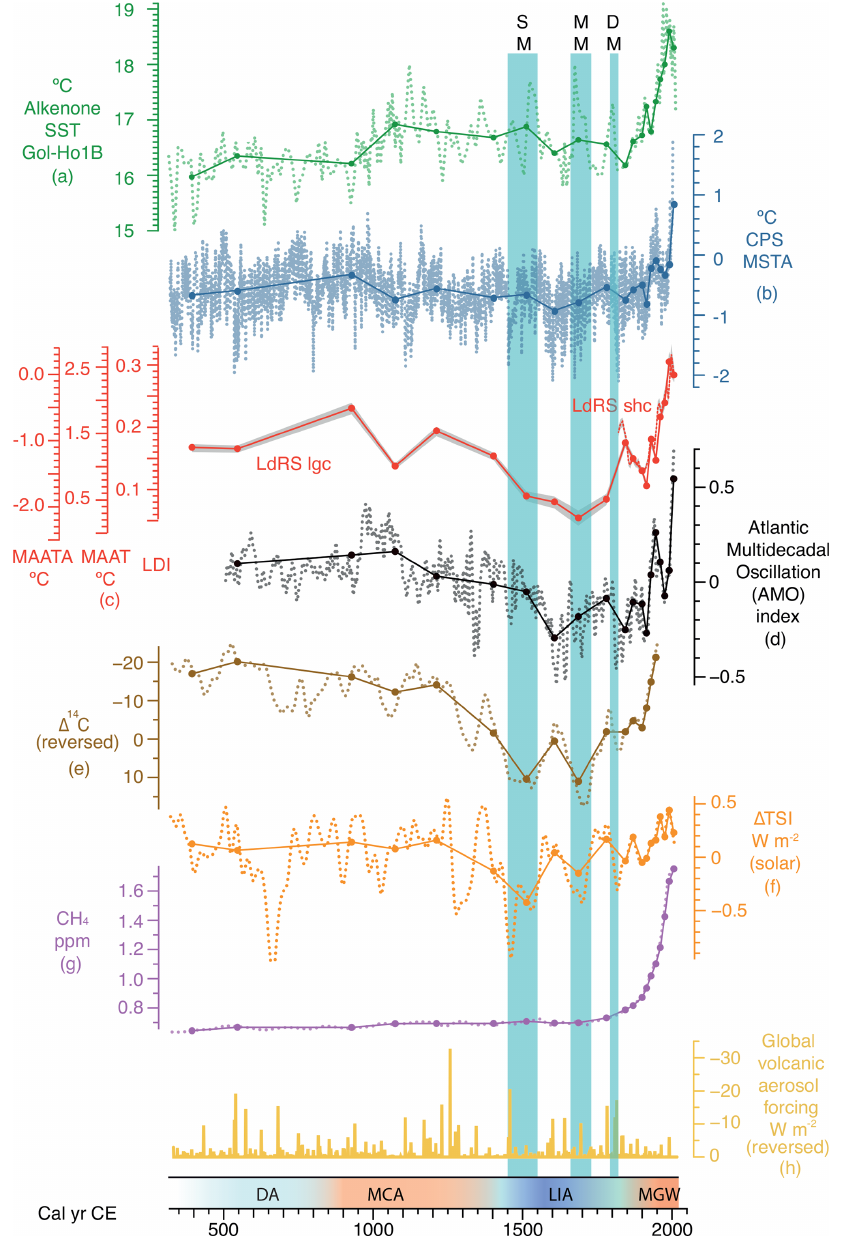
Figure 6. Comparison of the LDI record and the reconstructed temperatures for the last ∼ 1500 years of LdRS with marine and terrestrial temperature records, Atlantic multidecadal oscillations, solar radiation, greenhouse gases, and volcanic eruption records. Original data are shown by dashed lines. Solid dots represent the same time averaging as the LDI data in LdRS lgc (data were linearly interpolated and time averaged to the same resolution as the sampling points of LdRS lgc) to facilitate the Pearson correlation: (a) alkenone sea surface temperatures (SST, ◦ C) of the core Gol-Ho1B_KSGC-31 (Gulf of Lion: NW Mediterranean Sea; Sicre et al., 2016). (b) Composite-plus- scaling (CPS) mean summer temperature anomaly reconstruction from tree-ring records in Europe with respect to 1974–2003CE (MSTA, ◦ C) (Luterbacher et al., 2016). (c) LDI record along with the reconstructed mean annual air temperatures (MAAT, ◦ C) and mean annual air temperature anomalies with respect to 1979–2008CE (MAATA, ◦ C) for the last 1500 years in LdRS; (d) Atlantic Multidecadal Oscillation (AMO) reconstruction (Mann et al., 2009); (e) (cid:49) 14 C in the atmosphere (reversed) (Reimer et al., 2013); (f) reconstruction of the difference of the total solar irradiance from the value of the PMOD composite series during the solar cycle minimum of the year 1986CE (1365.57 Wm − 2 ) ( (cid:49) TSI) (Steinhilber et al., 2009); (g) reconstructed concentration of atmospheric CH 4 (ppm) (Schmidt et al., 2011); and (h) reconstruction of the global volcanic aerosol forcing (Wm − 2 ) (reversed) (Sigl et al., 2015). Acronyms: DA, dark ages; MCA, Medieval Climate Anomaly; LIA, Little Ice Age; MGW, modern global warming. Blue bars show three low-solar-activity periods, the Spörer Minimum (SM), the Maunder Minimum (MM), and the Dalton Minimum